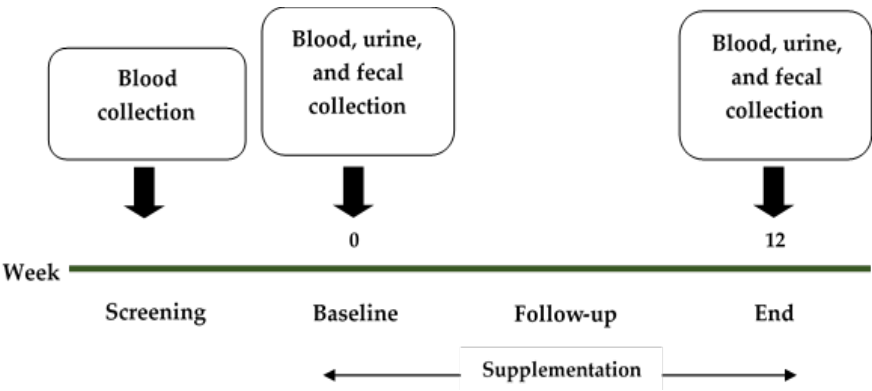
Figure 2. The timeline of this study, with sample collection points.